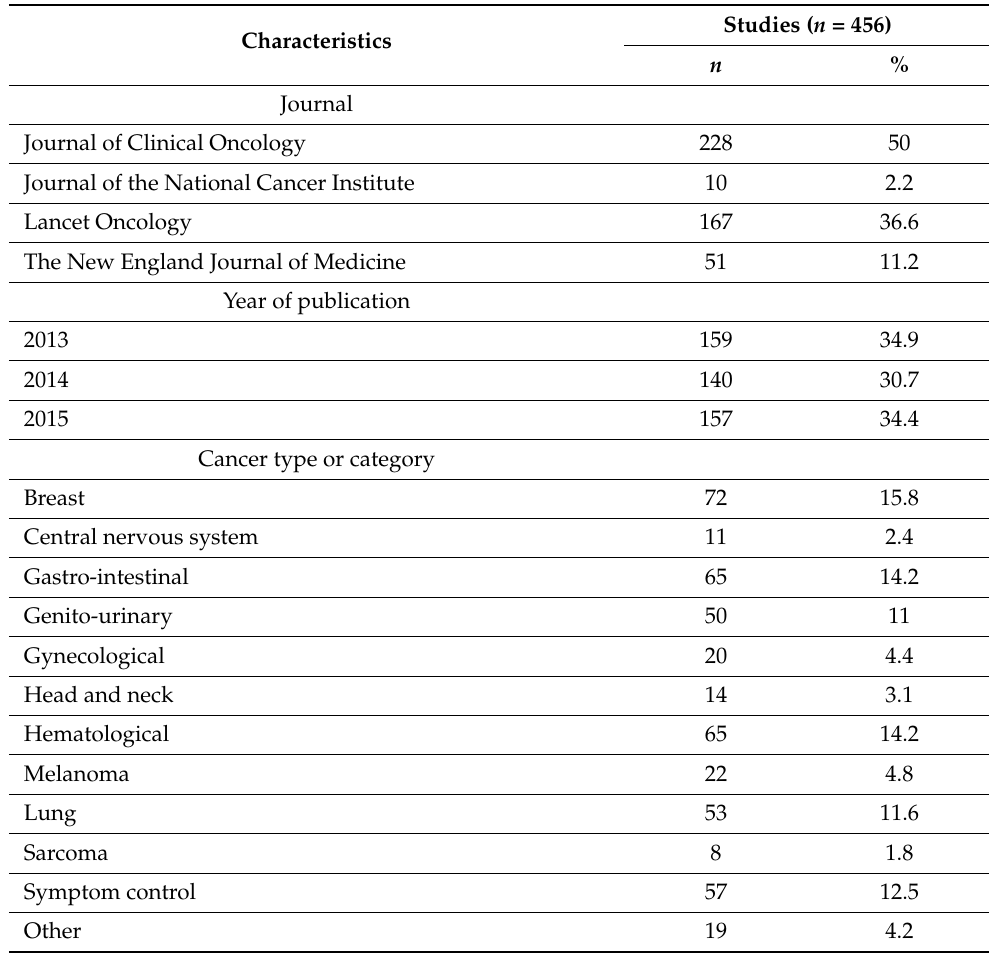
Figure 2. Flow diagram of the selection of randomized controlled trials in the review. Table 2. Trial characteristics.